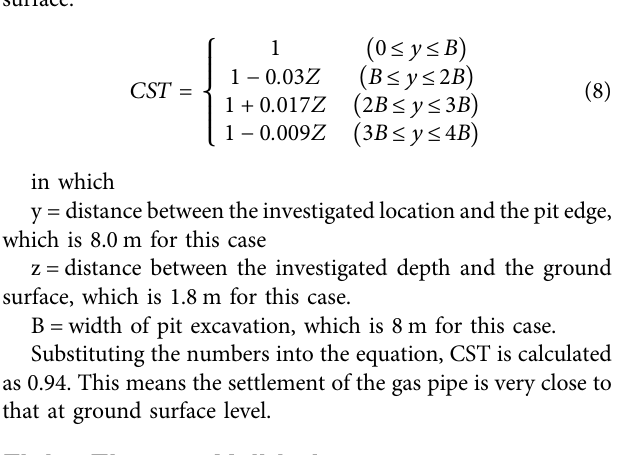
Monitored water table